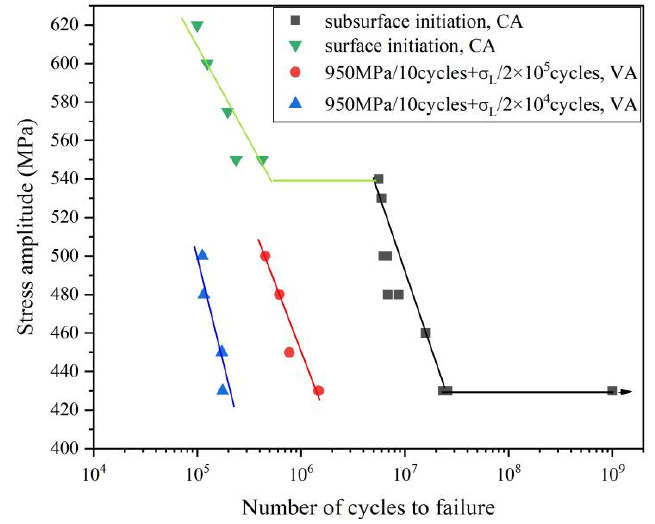
Figure 3. S-N curves under constant and variable amplitude loading for TC21 alloy (arrows denote the run-out specimens).